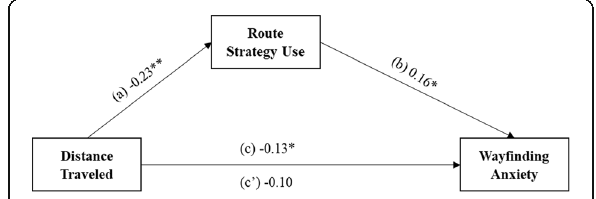
Fig. 9 Direct and indirect effects of distance traveled on route strategy through the mediator wayfinding anxiety, controlling for participant sex and trait anxiety. * p < .05, ** p < .01, *** p <